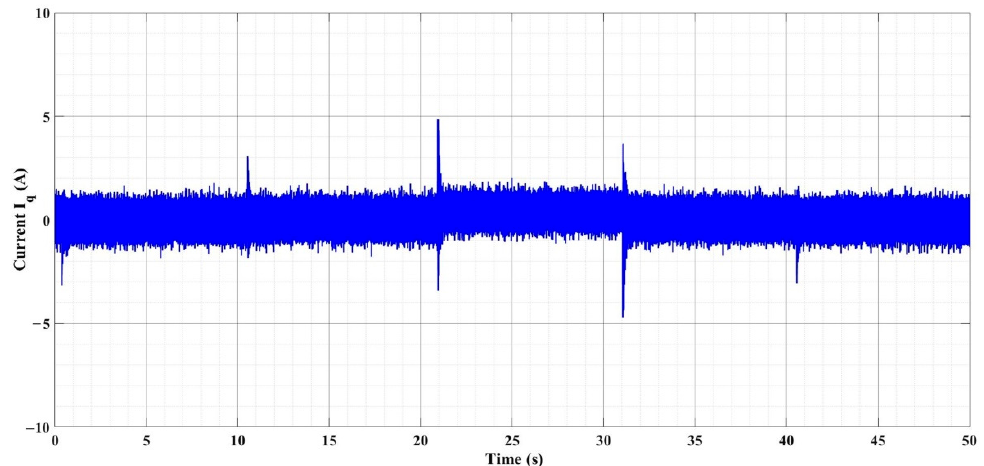
Figure 38. Real-time evolution for i a and i b stator currents—HIL stage; T L = 1 Nm.